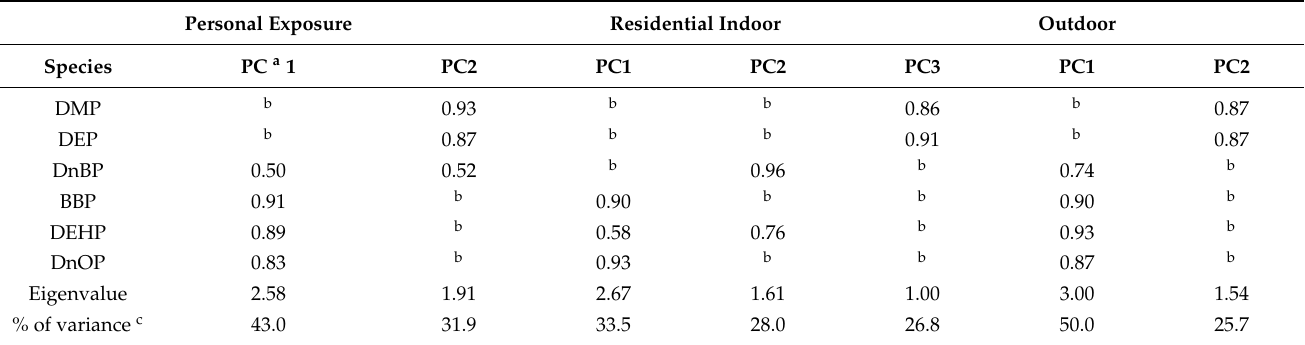
Table 5. Factor loading of principal component analysis (PCA) on PAEs in personal exposure, residential indoor, and outdoor PM 2.5 . Varimax with Kaiser